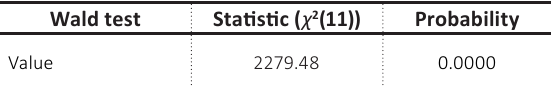
Table 13. Modified Wald test for heteroscedasticity across